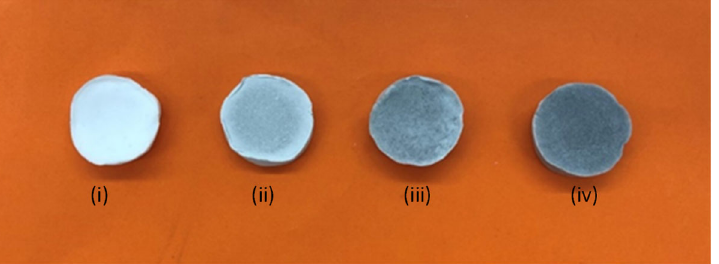
Figure 1. From left to right: ( i ) PCL; ( ii ) PCL/0.3% rGO; ( iii ) PCL/0.6% rGO and ( iv ) PCL/1% rGO.